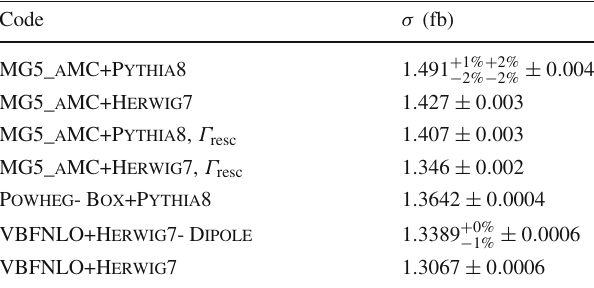
Table 7 Cross sections at NLO+PS accuracy. The MG5_aMC results with Γ resc are rescaled to account for the effect related to the W- boson width computed by MadSpin (see the text for details). For VBFNLO + Herwig7- Dipole , the three-point scale uncertainties are shown, while for MG5_aMC + Pythia8 the two displayed uncertainties are respectively the nine-point scale uncertainty and the PDF one. The uncertainties shown refer to estimated statistical errors of the Monte Carlo